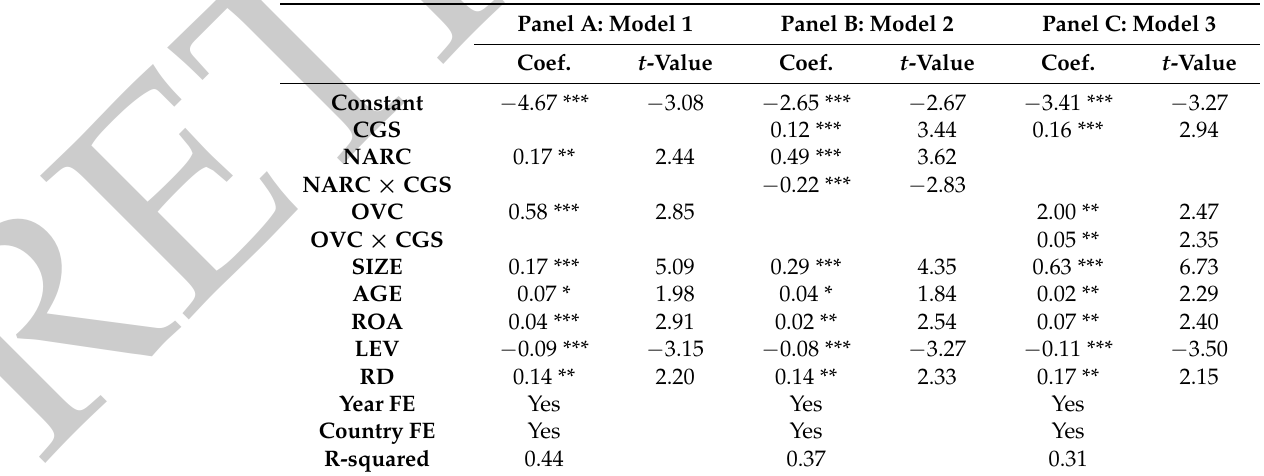
Table 8. Second robustness test (#Obs.